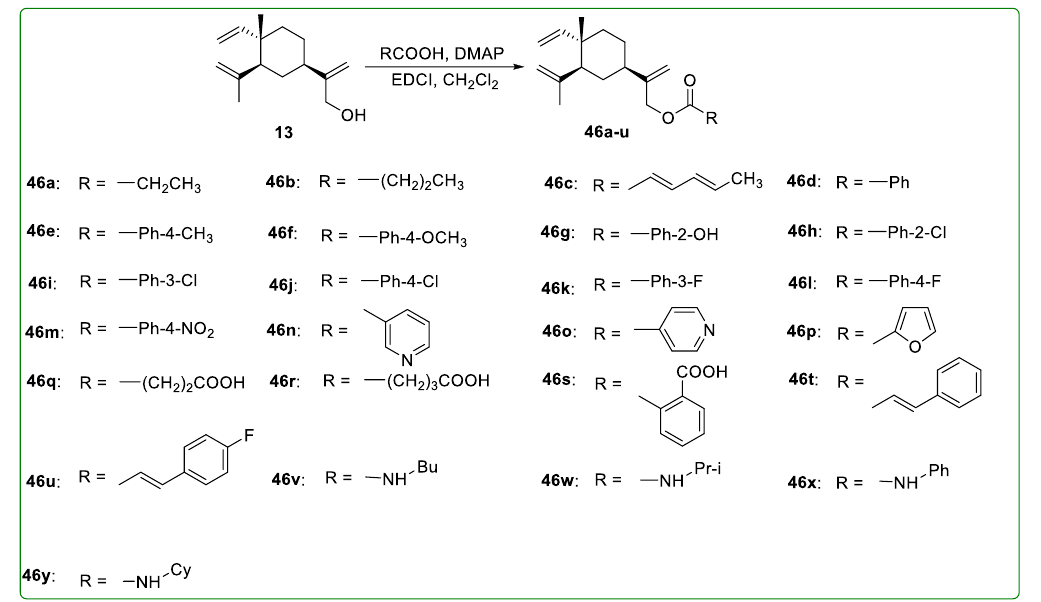
Figure 15. Chemical structures of β -elemene ester derivatives 46a – y .